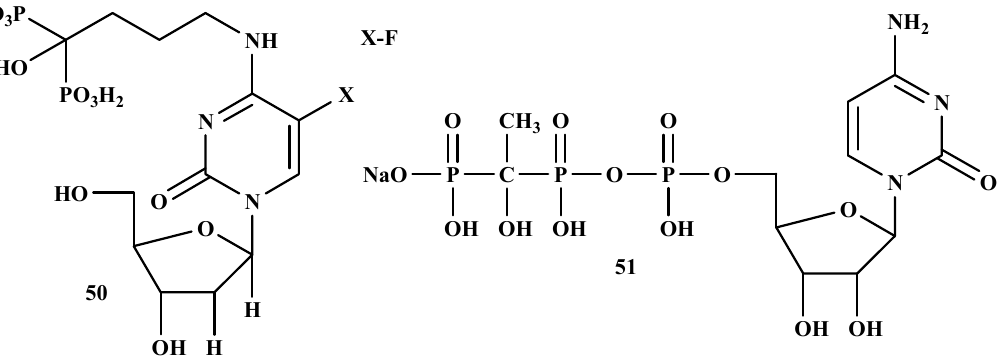
Figure 10. Structures of BP ‐ conjugates with anti ‐ breast cancer activity 50, 51 .